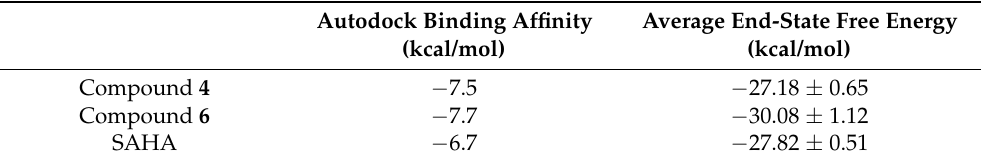
Table 1. The Autodock binding affinities for each selected conformation, and end-state free energies of the molecular dynamics simulations.